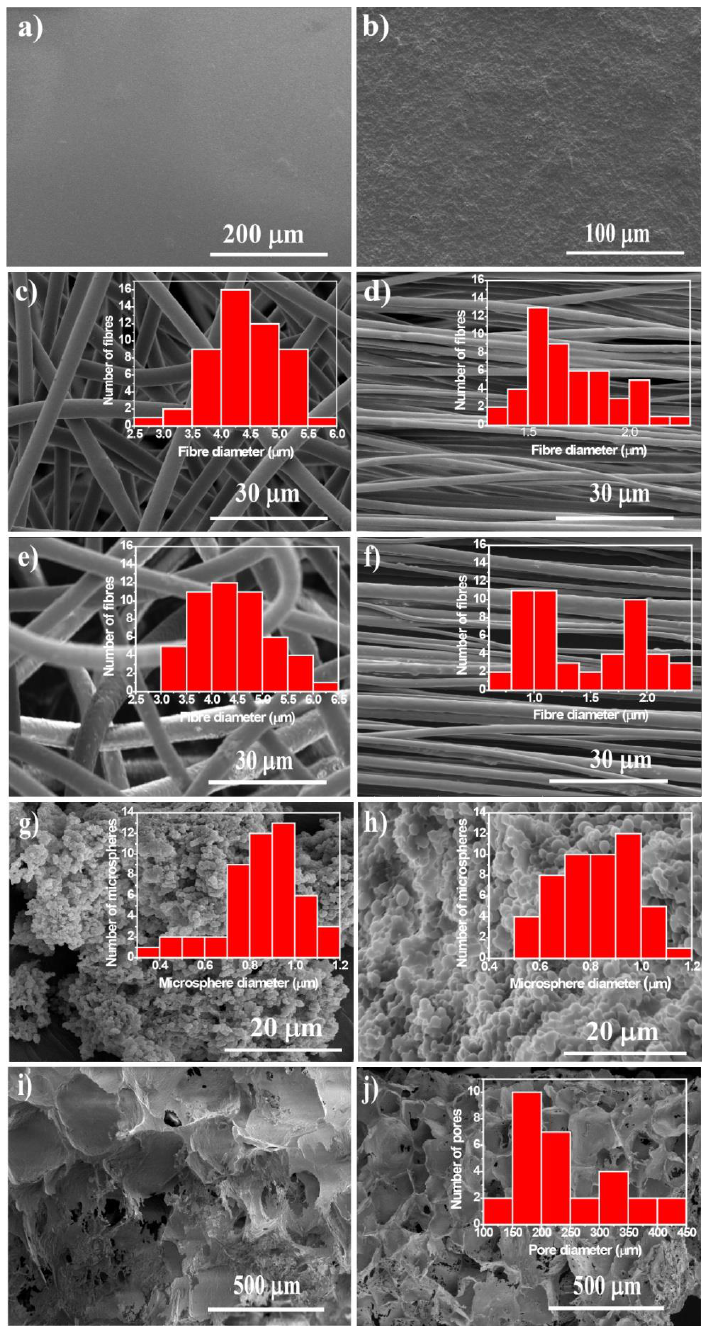
Figure 1. PHBV morphologies: ( a ) neat PHBV films; ( b ) CFO films; ( c ) R fibers; ( d ) O fibers; ( e ) R CFO fibers; ( f ) O CFO fibers; ( g ) neat PHBV microspheres; ( h ) CFO microspheres; ( i ) scaffolds; ( j ) CFO scaffolds. The histograms with the corresponding fiber, sphere, and pore diameters are presented as figure inset.